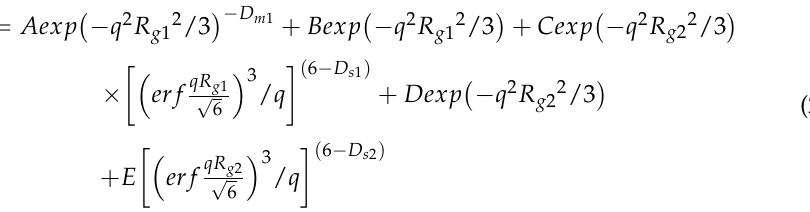
(4) (3) The curve (solid red line) calculated using Equation (3) using radius R g2 agreed well with the experimental results (black dots). The best-fitting values were R g2 = 1.3, D m2 = 2.7,